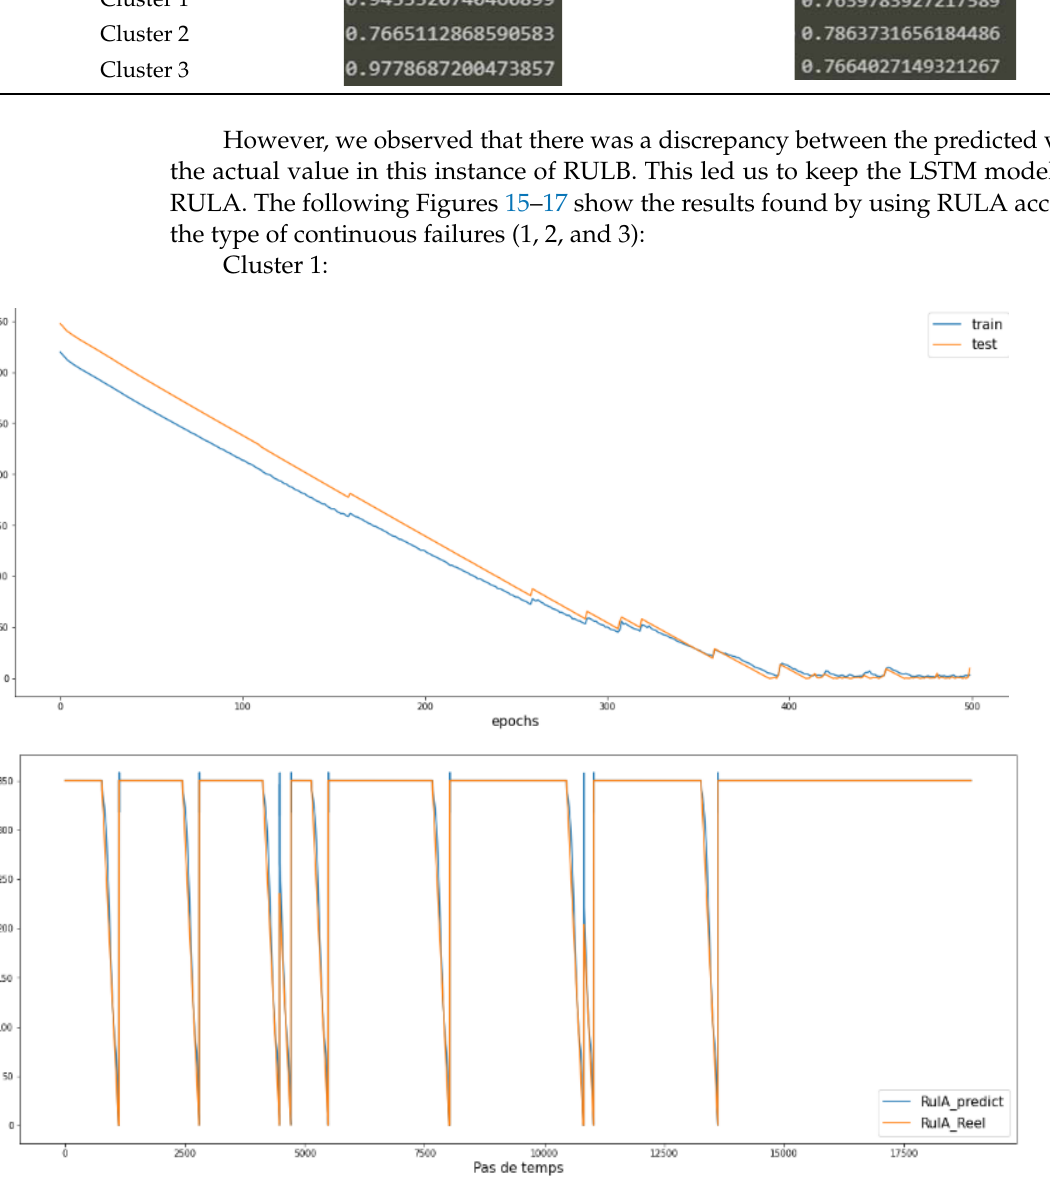
Figure 15. LSTM method for cluster 1 continuous-RULA. Mean squared error = 147.2550818147693. Cluster 2: